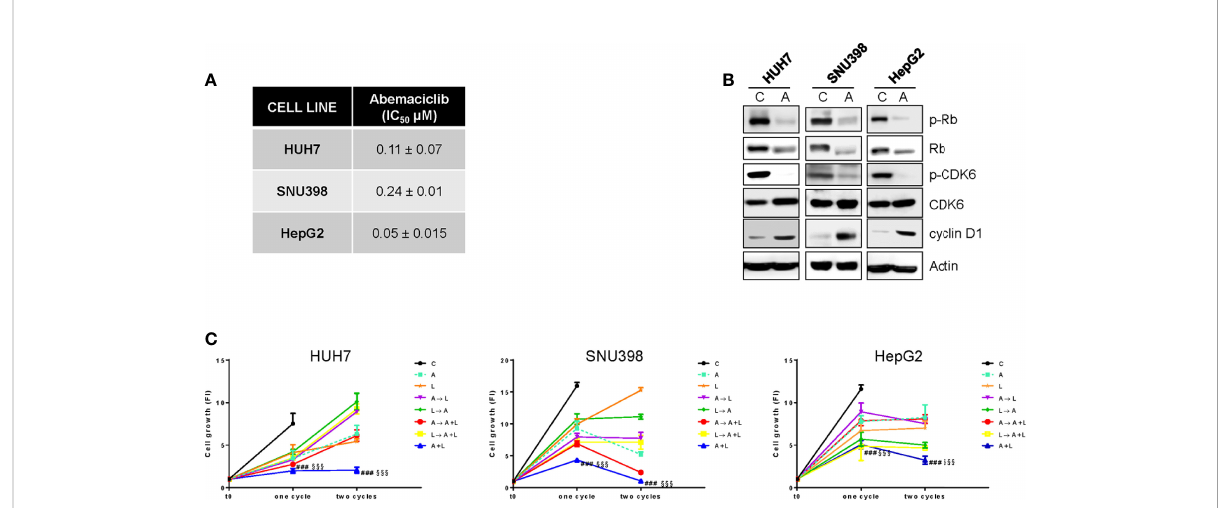
FIGURE 1 The simultaneous combined treatment of abemaciclib and lenvatinib inhibits cell proliferation more strongly than single agents and sequential schedules in HCC cells. (A) After 24h from seeding, HUH7, SNU398, and HepG2 cells were treated with increasing concentrations of abemaciclib (A) for 6 days. Cell proliferation was evaluated by CV assay and the IC 50 values were calculated using GraphPad Prism 6.00 software. (B) HCC cells were untreated (Control, C) or treated with 1 m M A for 24h. The cells were lysed and the expression of the indicated proteins was evaluated by Western blot analysis. (C) HUH7, SNU398, and HepG2 cells were treated with A or L at their corresponding IC50 values for 6 days (one cycle), or 12 days (two cycles), alone or with different combinations of the two drugs: A for 72h followed by L for 72h (A ! L), L for 72h followed by A for 72h (L ! A), A for 72h followed by A+L for 72h (A ! A+L), L for 72h followed by A+L for 72h (L ! A+L), or a simultaneous combination for 6 days (A+L) for each cycle. The growth medium with drugs was refreshed every 3 days. Cell proliferation was evaluated by CV assay. Data are expressed as Fold Increase (FI). The FI index was calculated as the ratio between cell proliferation after 6 or 12 days and cell proliferation at T 0 (T 0 = 24h after seeding). ### p<0.001 vs A; §§§ p<0.001, vs L. Data in A are mean values ± SD of three independent experiments. Data in B-C are representative of two independent